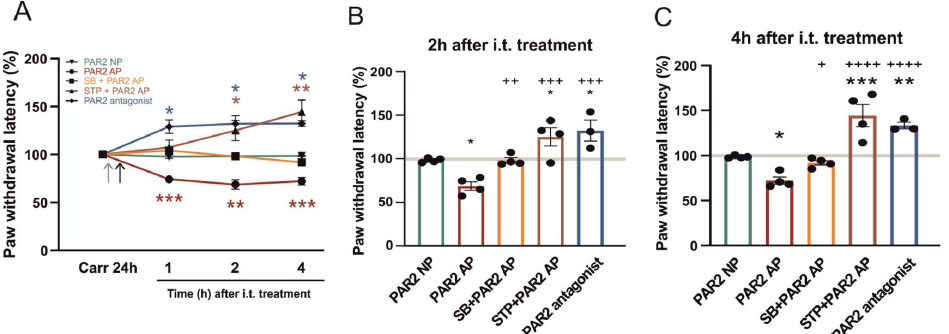
Figure 1. The effect of spinal protease-activated receptor 2 (PAR2) activation and inhibition on carrageenan-induced thermal hyperalgesia. ( A ) Thermal hypersensitivity measured 24 h after the carrageenan injection, just before the intrathecal (i.t.) treatments were considered as 100%. The administration of the inactive reverse peptide PAR2 NP ( n = 4) did not change the thermal threshold any further. In comparison, PAR2-activating peptide (AP) administration ( n = 4) decreased the paw withdrawal latency (PWL) to the radiant heat stimulation for several hours. The transient receptor potential vanilloid 1 (TRPV1) antagonist SB 366791 (SB, n = 4) pretreatment prevented the PAR2 AP-induced decrease of PWL. Staurosporine (STP, n = 4) pretreatment also prevented the PAR2 AP-induced effect, and the thermal threshold even increased (2 h and 4 h). PAR2 antagonist ( n = 3) administration increased the PWL for several hours (1 h, 2 h and 4 h). Grey arrowhead: SB 366791 or staurosporine i.t. pretreatment. Black arrowhead: PAR2 NP, PAR2 AP or PAR2 antagonist i.t. treatment. Statistical differences were identified using Kruskal-Wallis one-way ANOVA for each group; * p < 0.05, ** p < 0.01 and *** p < 0.001, comparison with the control before i.t. treatment. ( B , C ) A detailed comparison of various treatments at 2 and 4 h after the i.t. treatment. Statistical differences between groups with various treatments were identified using one-way ANOVA followed by the Student-Newman-Keuls (SNK) test; * p < 0.05, ** p < 0.01 and *** p < 0.001, comparison with